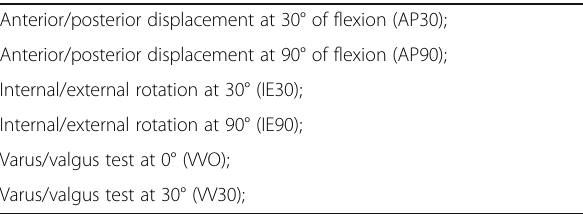
Table 1 Kinematic tests performed Anterior/posterior displacement at 30° of flexion (AP30); Anterior/posterior displacement at 90° of flexion (AP90); Internal/external rotation at 30° (IE30); Internal/external rotation at 90° (IE90); Varus/valgus test at 0° (VVO); Varus/valgus test at 30°